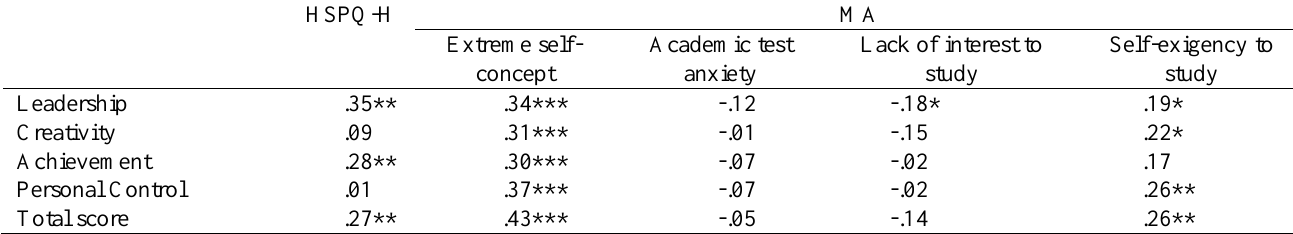
Table 2: Correlation matrix among ATE factors and HSPQ-H and MA